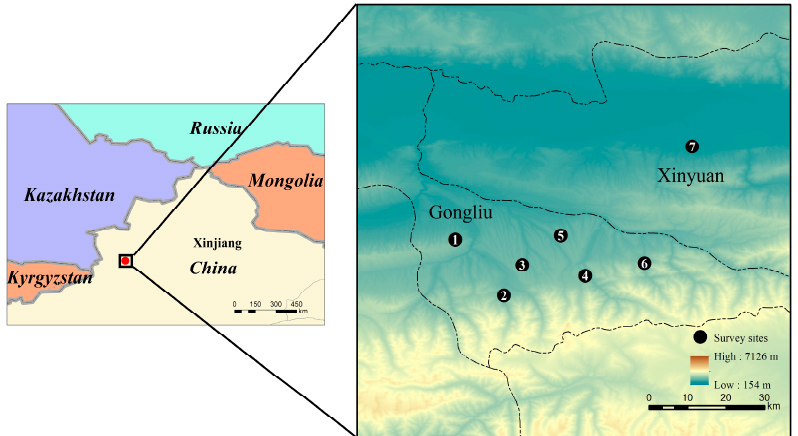
Figure 1. Location of survey sites in Yili River Valley of Xinjiang Uyghur Autonomous Region, China. The symbols in the map indicate the seven survey sites in the Yili River valley (1: Erxiang; 2: Damohe; 3: Xiaomohe; 4: Balian; 5: Jiaolesai; 6: Saha; and 7: Xinyuan).